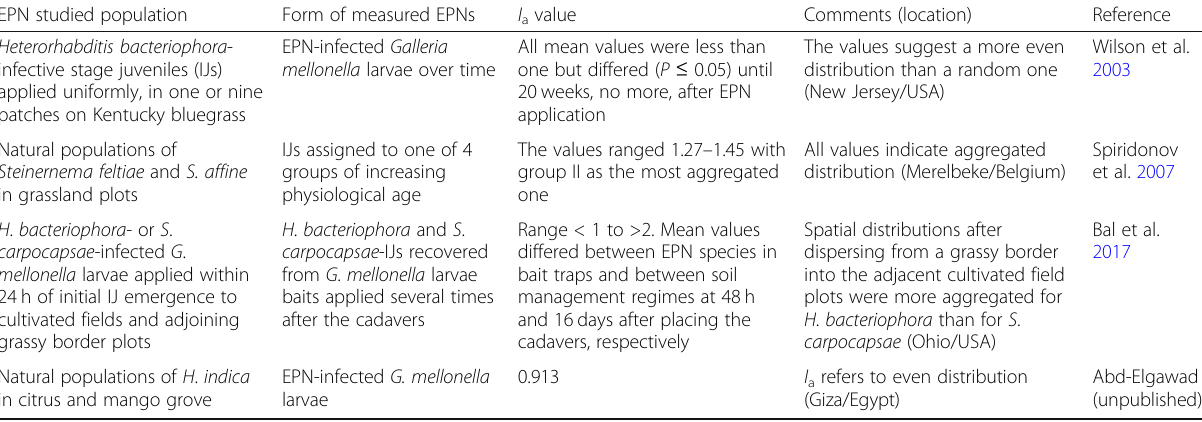
Table 1 Comparison of index of aggregation ( I a ) (the observed value of distance to regularity/the mean randomized value (Perry 1995)) values of four different studies on entomopathogenic nematode distributions using different approaches in various regions EPN studied population Form of measured